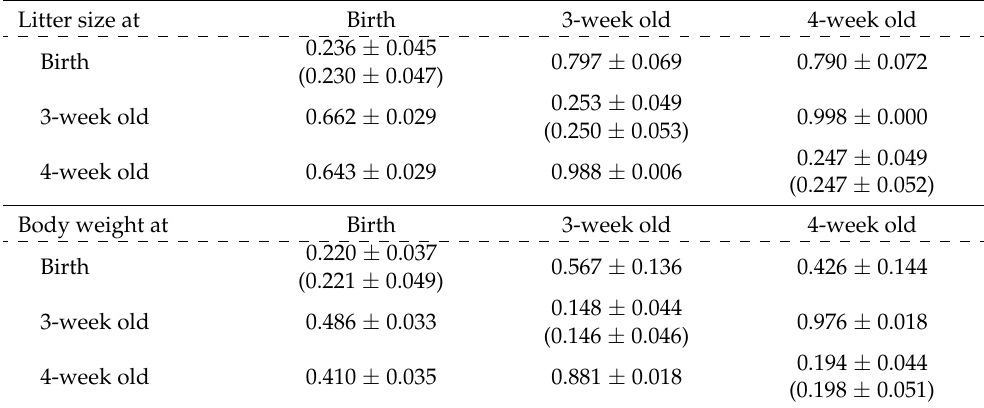
Table 2. Estimates of heritability (h 2 , diagonals), genetic correlations (r g , upper diagonals), and phe- notypic correlations (r p , lower diagonals) of littering performance before weaning with SE using animal models without maternal genetic effects in a three-trait animal model. Litter size at